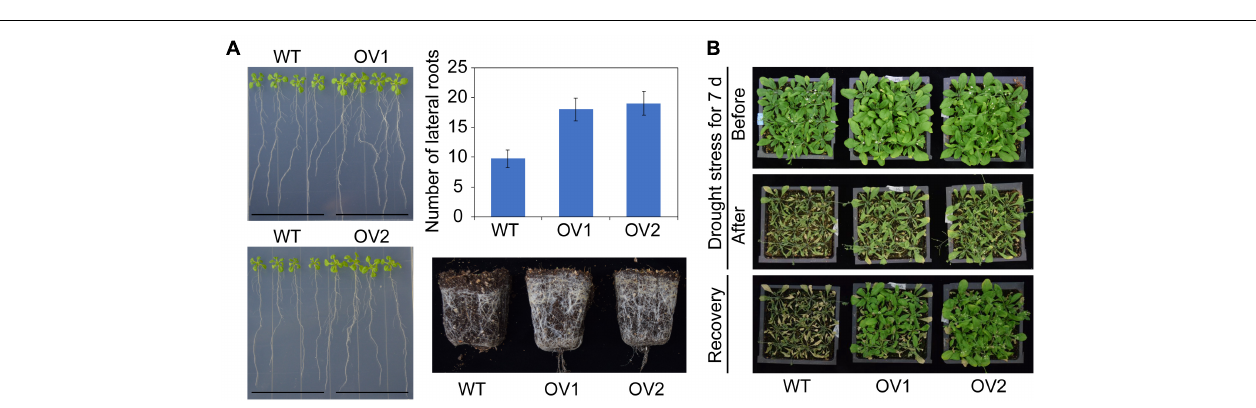
FIGURE 4 | Promoted lateral root (LR) formation (A) and enhanced drought tolerance (B) in transgenic Arabidopsis plants overexpressing IbRAP2.4 (OV1 and OV2). Data represent mean ± SD of three biological replicates.